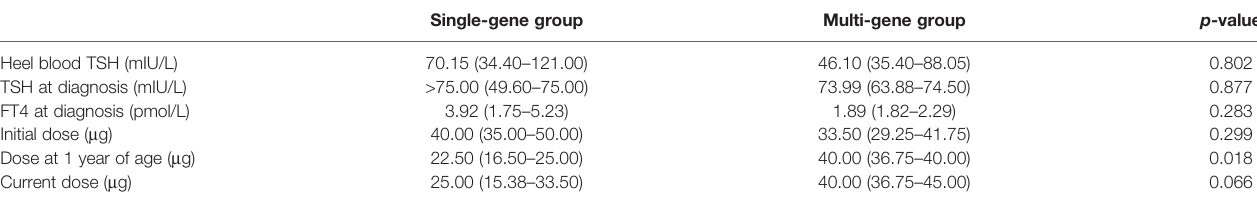
TABLE 4 | Comparison of the clinical characteristics in the single-gene and multi-gene groups.